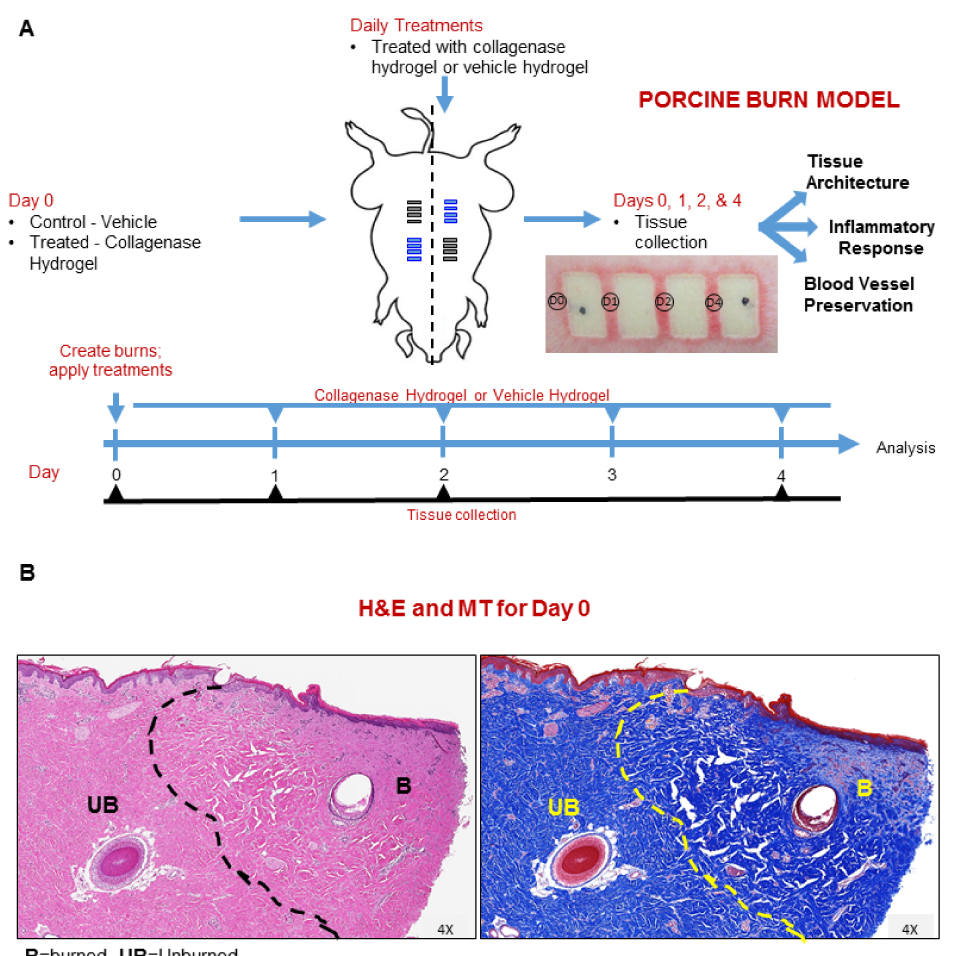
Figure 1. Burn study design schematic and treatment protocol. ( A ) Animals received Clostridium collagenase treatment daily. Tissues were collected at 0, 1, 2, 4 and 7 days post-burn from different burn wound interspaces from comb burns on two pigs and processed for histology. Black bars indicate location for vehicle hydrogel treatment and blue bars indicate collagenase hydrogel treatment location on porcine drawing. ( B ) Representative H&E and MT section stains for day 0 tissues collected. Areas of burned ‘B’ and unburned ‘UB’ tissue are indicated to demonstrate the focus area at the burn